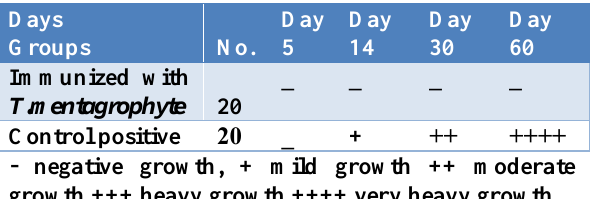
Table, 2: Show fungal isolation in immunized and non-immunized mice with T.mentagrophyte Ags (1 st group) and control(2 nd group) after 5 ,14, 30,and 60 day post challenge